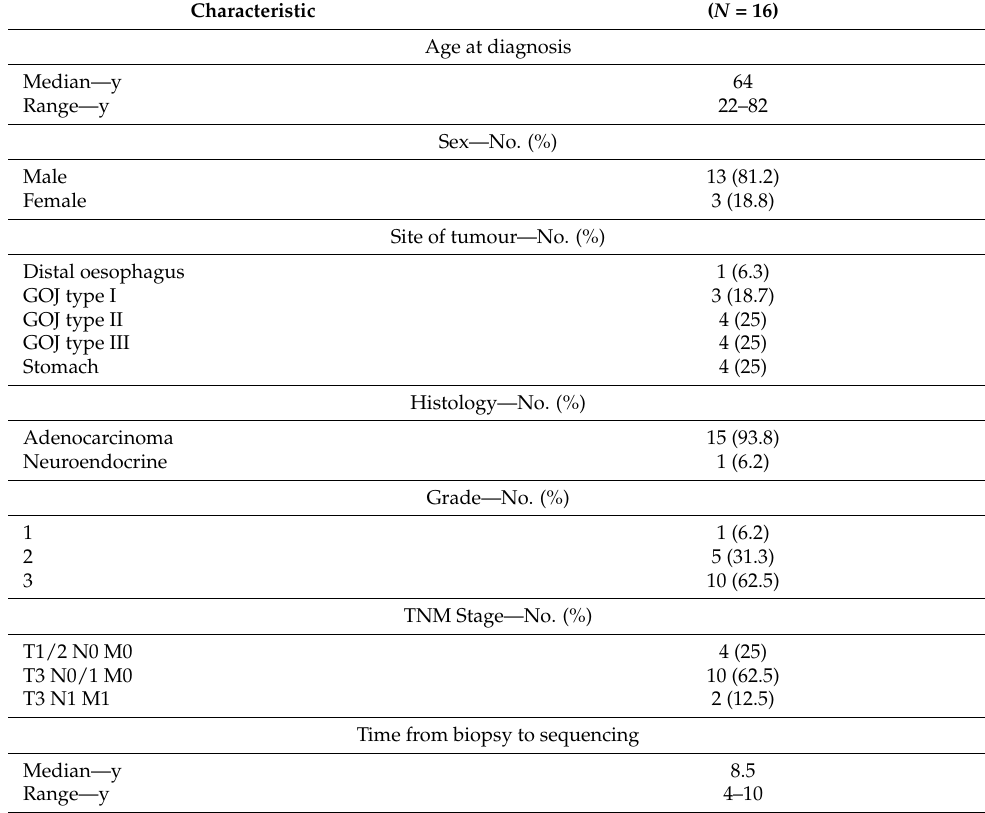
Table 1. Clinicopathological characteristics of